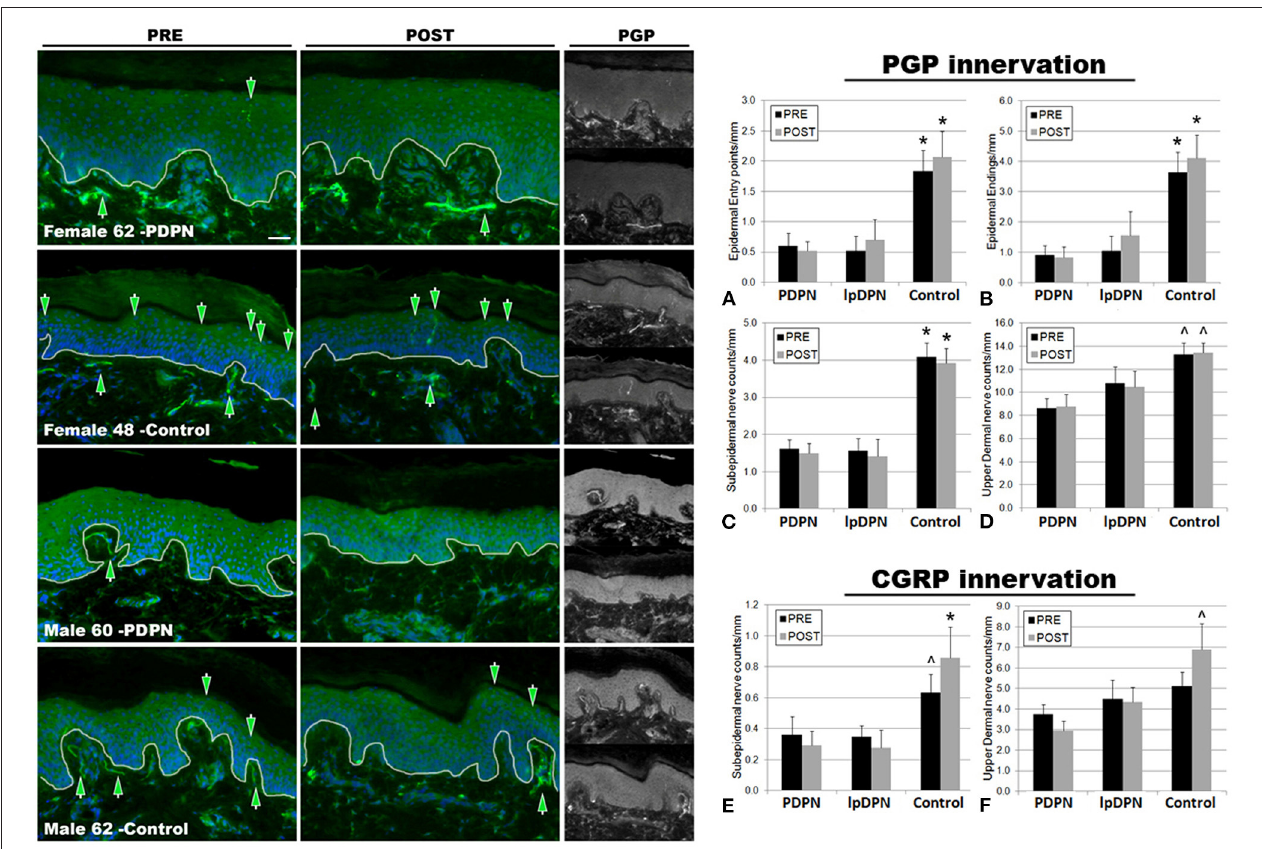
FIGURE 3 | PGP9.5 + cutaneous innervation. The panels depict representative images of PGP immunolabeling and DAPI fluorescence, PRE (pre-treatment period) and POST (post-treatment period) topical 5% lidocaine patch treatment, along with the half-sized grayscale PGP images used for counting, from a female and male PDPN patient compared with control. Thin white lines in the color images indicate the dermal/epidermal junction. Mag bar = 50 µ M. Analysis of intraepidermal nerve fiber (IENF) measures (A) epidermal entry points and (B) epidermal endings, as well as (C) subepidermal axons and (D) upper dermal nerves, demonstrated significant losses across all cutaneous innervation sets from both PDPN and lpDPN cohorts compared with Control subjects. No innervation measures differentiated between the PDPN and lpDPN cohorts, and the 4-week topical 5% lidocaine treatment protocol had no significant effect on the innervation loss. Analysis of CGRP-positive (peptidergic) innervation revealed similar losses among the (E) subepidermal and (F) upper dermal compartments. CGRP-positive IENF were not identified among our human cohort biopsies (see results). *significant vs. PDPN and lpDPN; ∧ significant vs.